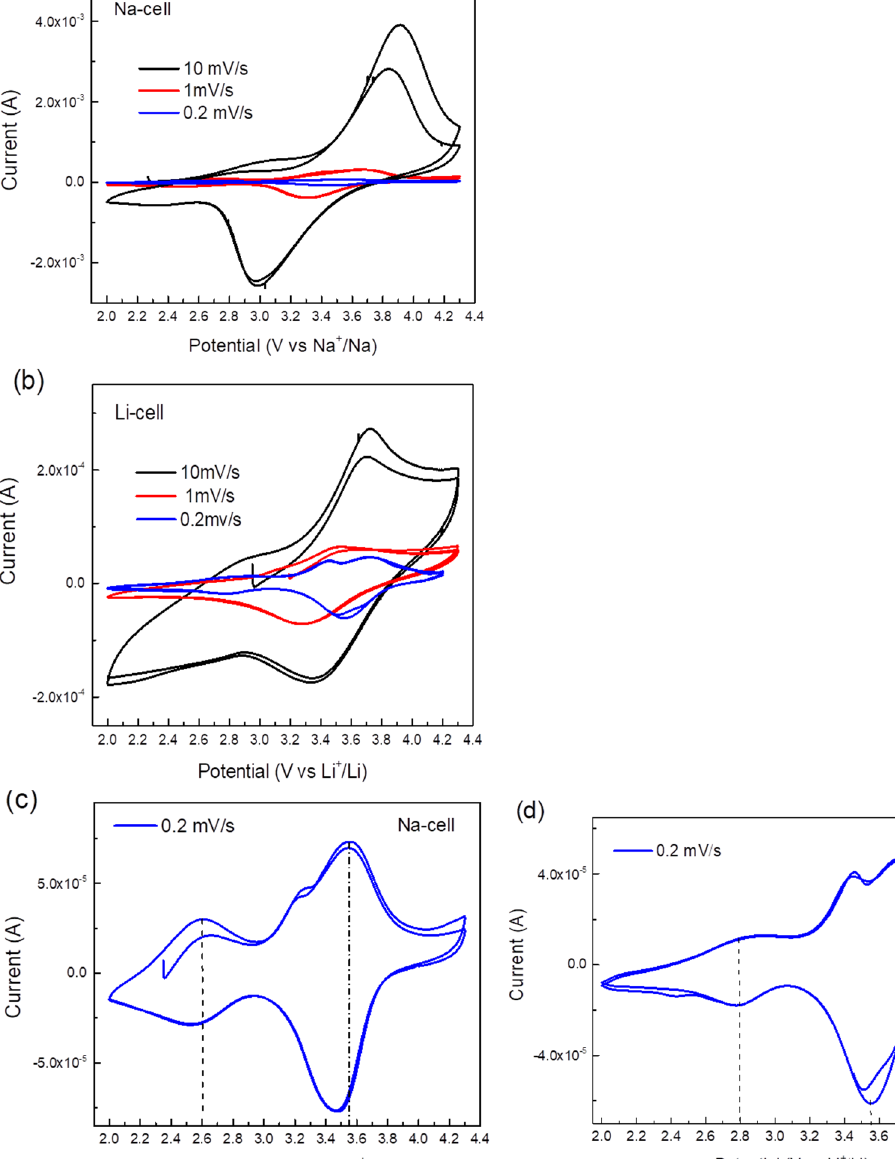
Figure 3. ( a ) Cyclic voltammetry (CV) curves of a TiHCF Na-ion half-cell at a different scan rate (two cycles at each scan rate); ( b ) CV curves of a TiHCF Li-ion half-cell at different scan rate (two cycles at each scan rate); ( c ) CV of TiHCF Na-cell at 0.2 mV/s; ( d ) CV of TiHCF Li-cell at 0.2 mV/s. The cycling performance of TiHCF in Na-ion and Li-ion half cells are shown in Figure 4a, b. TiHCF exhibits good capacity retention: 94.5% and 89.9% of the discharge capacity values were retained after 50 cycles in the Na and Li coin cells, respectively. 3.0–4.0 V and >4.0 V voltage range) and the Li-cell (corresponding to the 2.3–3.0 V, 3.0–4.0